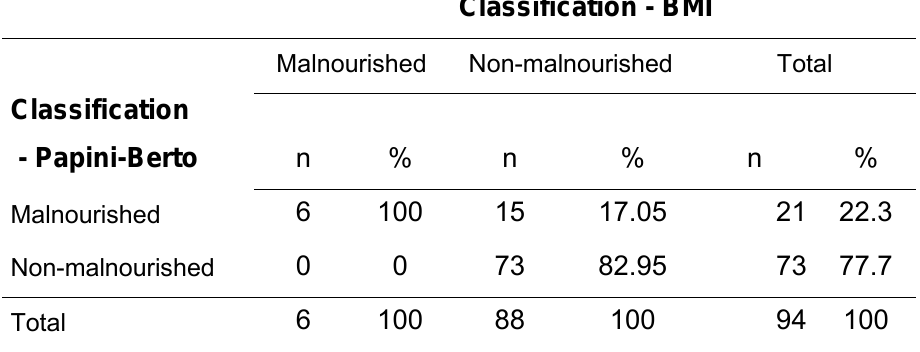
Table 2. Performance of the nutritional classification by Papini-Berto in relation to the BMI classification and agreement indexes in 94 HIV-positive patients undergoing HAART and assisted at the Nutrition and Tropical Diseases Outpatient Hospital, Botucatu Medical School - São Paulo State University (FMB - UNESP), 2003/04.